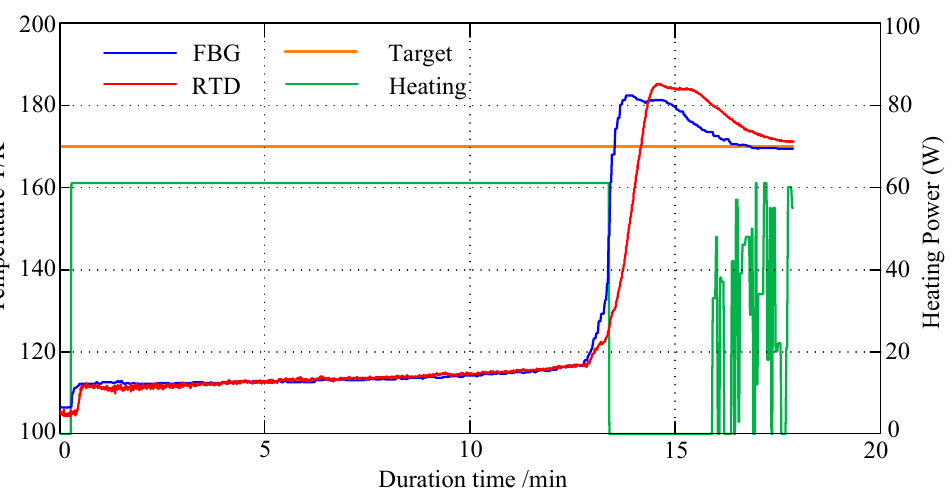
( b ) Figure 7. Measurement results of RTD and FBG: ( a ) comparison of measurement accuracy; ( b ) comparison of measurement stability.